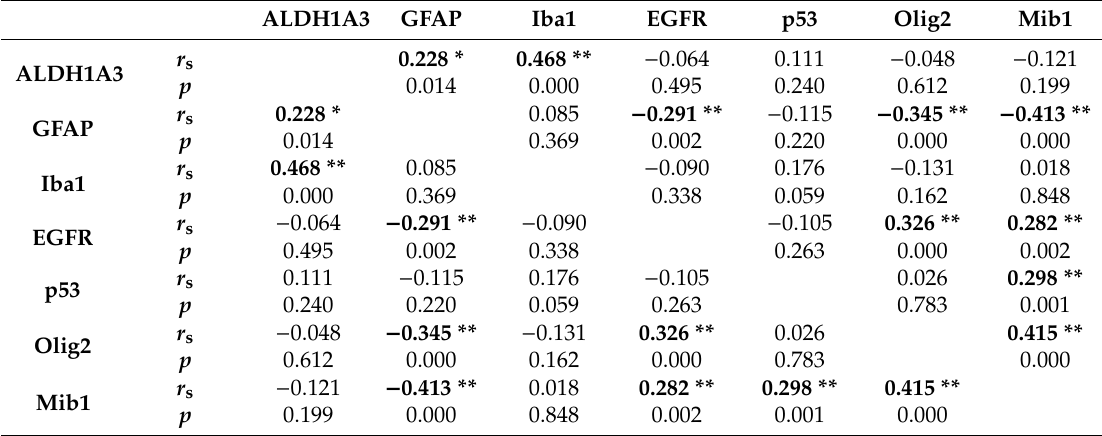
Table 1. Spearman-Rho correlation analysis.